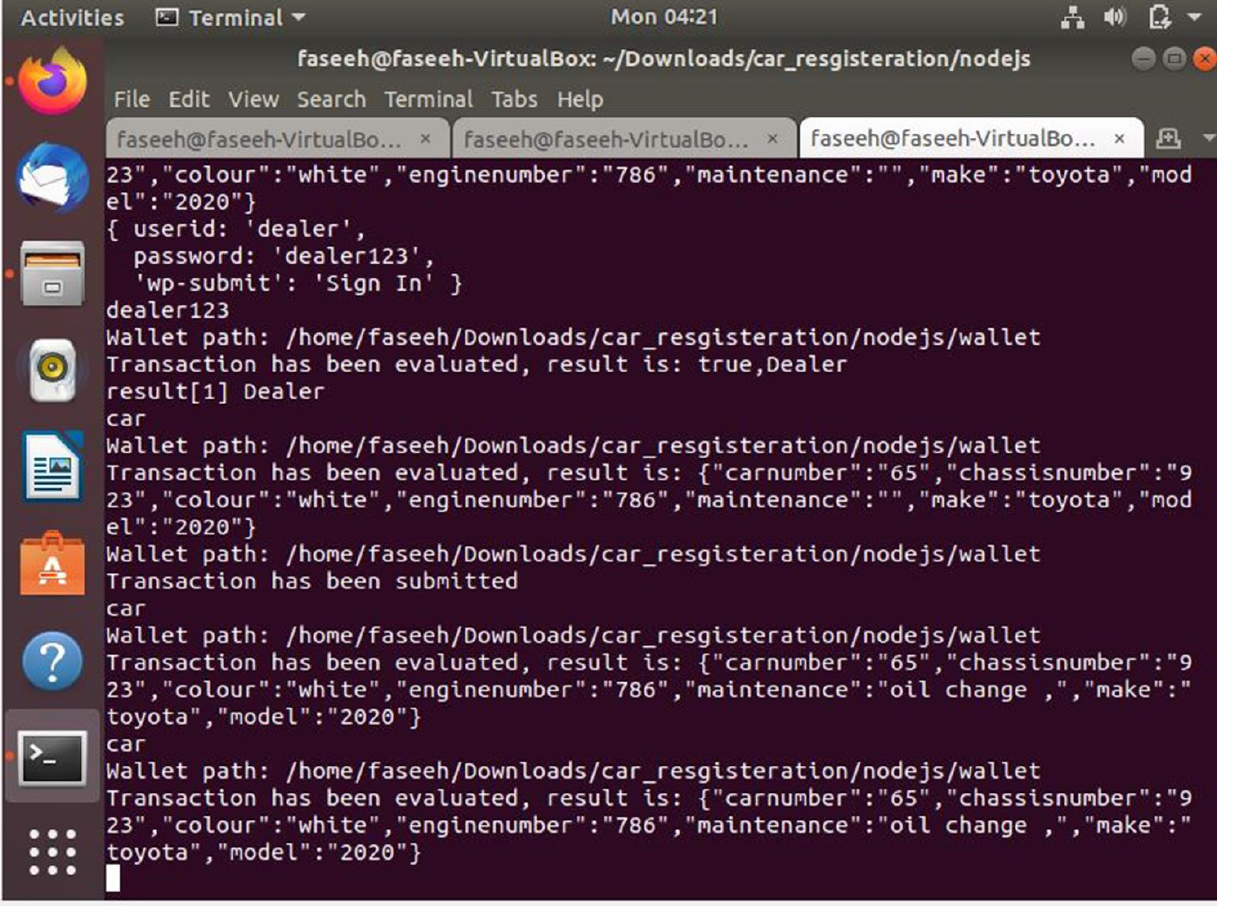
Figure 9. Blockchain backend updates.